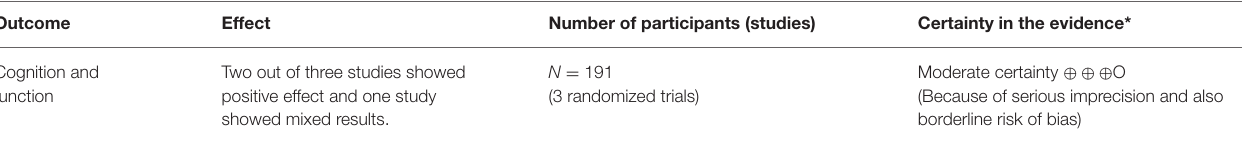
TABLE 4 | Summary of findings of narrative